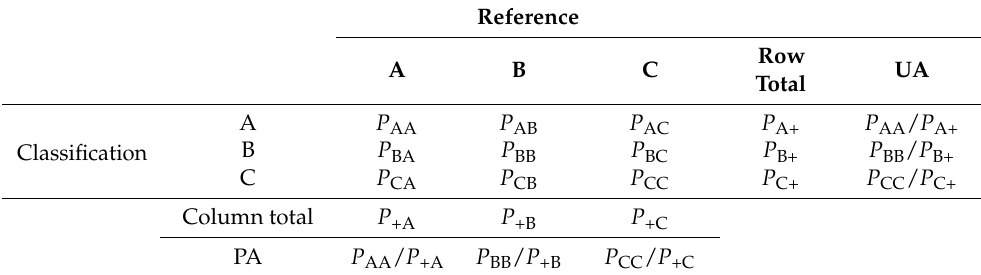
Table 1. The population confusion matrix. A, B, and C represent the class labels. P ij represents the proportion of the map area that is classified as class i and is class j in the reference data. The + symbol is used to represent summation, with the summation over a column for the + symbol in the first subscript position, and across the row in the second subscript position. UA = user’s accuracy and PA = producer’s accuracy.